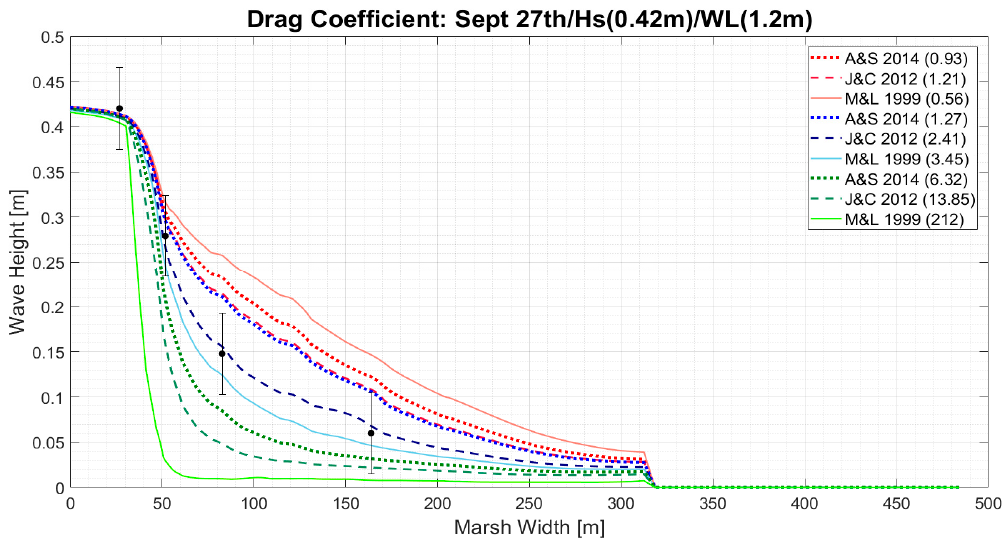
Figure 9. Comparison between the Anderson & Smith 2014 [10], the Jadhav & Chen 2012 [35] and the Mendez & Losada 1999 [8] drag formulations indicated in the legend. The graph is also color coded based on the highest (Red), lowest (Green) and average (Blue) current velocities produced by Delft3D on 27 September 2015. The current velocities are 0.7 m/s, 0.29 m/s and 0.1 m/s respectively. The magnitudes (in parentheses) next to the formulations are the drag coefficients that were calculated using the previously described current velocities. The black dots with the bars indicate a 20% error above and below the field data readings.